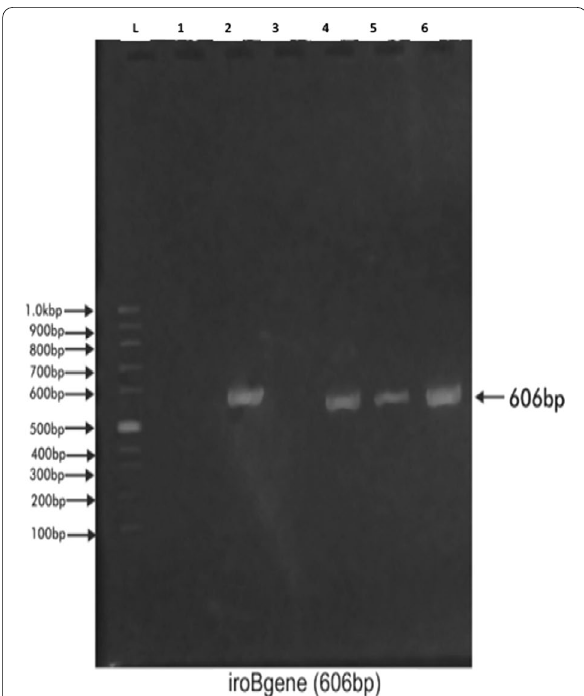
Fig. 2 PCR amplification of genomic DNA targeted to amplify the iro B virulence factor embedded in Salmonella enterica serovar typhimurium on 1.0% agarose gel electrophoresis. L Marker. 1